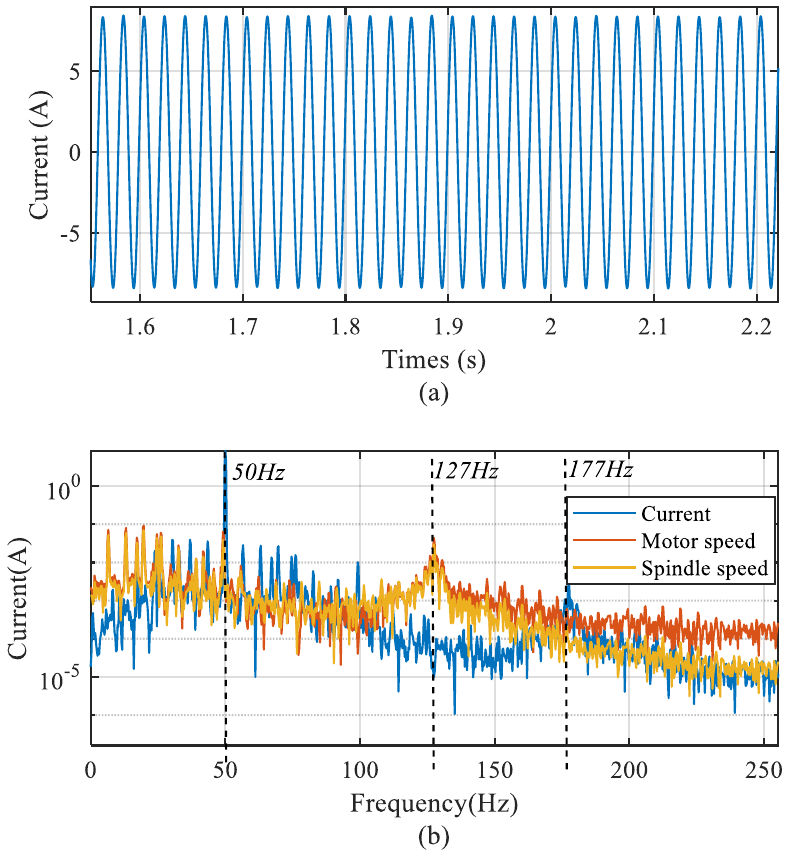
Figure 7. Motor current signature analysis results under 50% load: ( a ) time–domain current diagram and ( b ) spectra for current and speed responses.